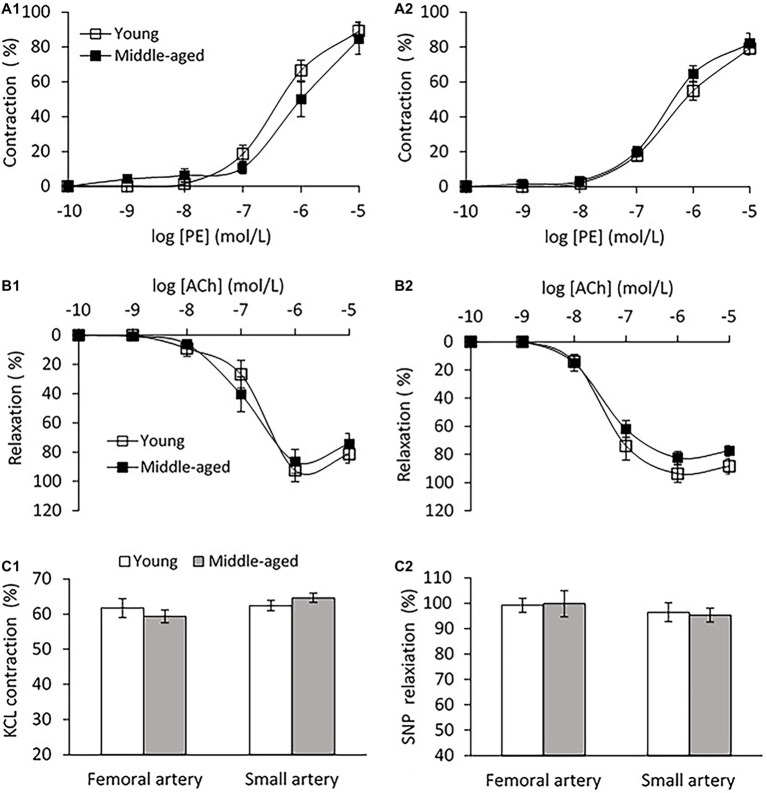
(A) Vascular contraction to phenylephrine (PE) in femoral artery (A1) and small peripheral artery (A2) between young and middle-aged pigs. (B) PE pre-contractile endothelium-dependent vasodilation to acetylcholine (ACh) in femoral artery (B1) and small peripheral artery (B2) between young and middle-aged pigs. (C) Vascular contraction to potassium chloride (KCL) at 60 mmol/L (C1) and maximal response of vasodilation to sodium nitroprusside (SNP) at 10−5 mol/L (C2) between young and middle-aged pigs in femoral and small peripheral artery. Data corresponds to means ± SEM.